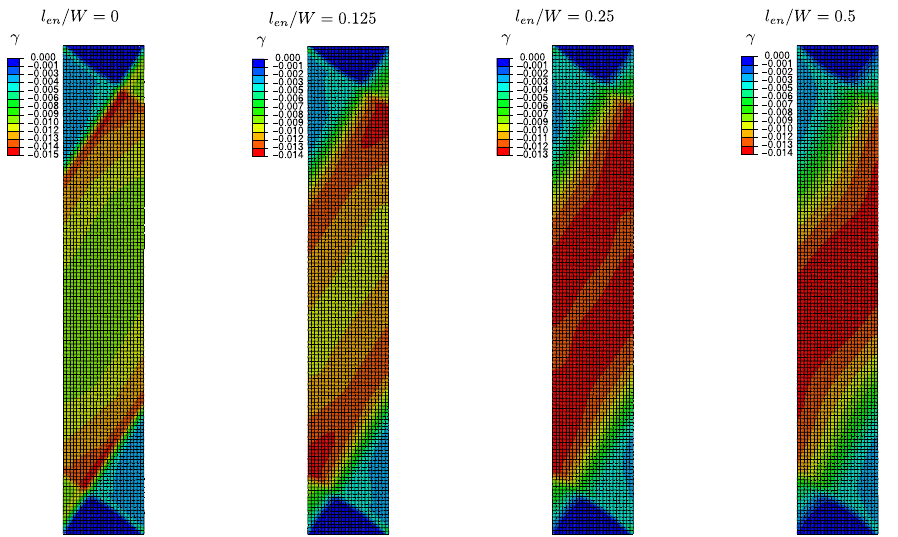
Figure 14. Influence of energetic length scale l en on the formation of the kink bands at the beginning of straining ∆ L / L 0 = 0.006 ( l dis = 0 ) .